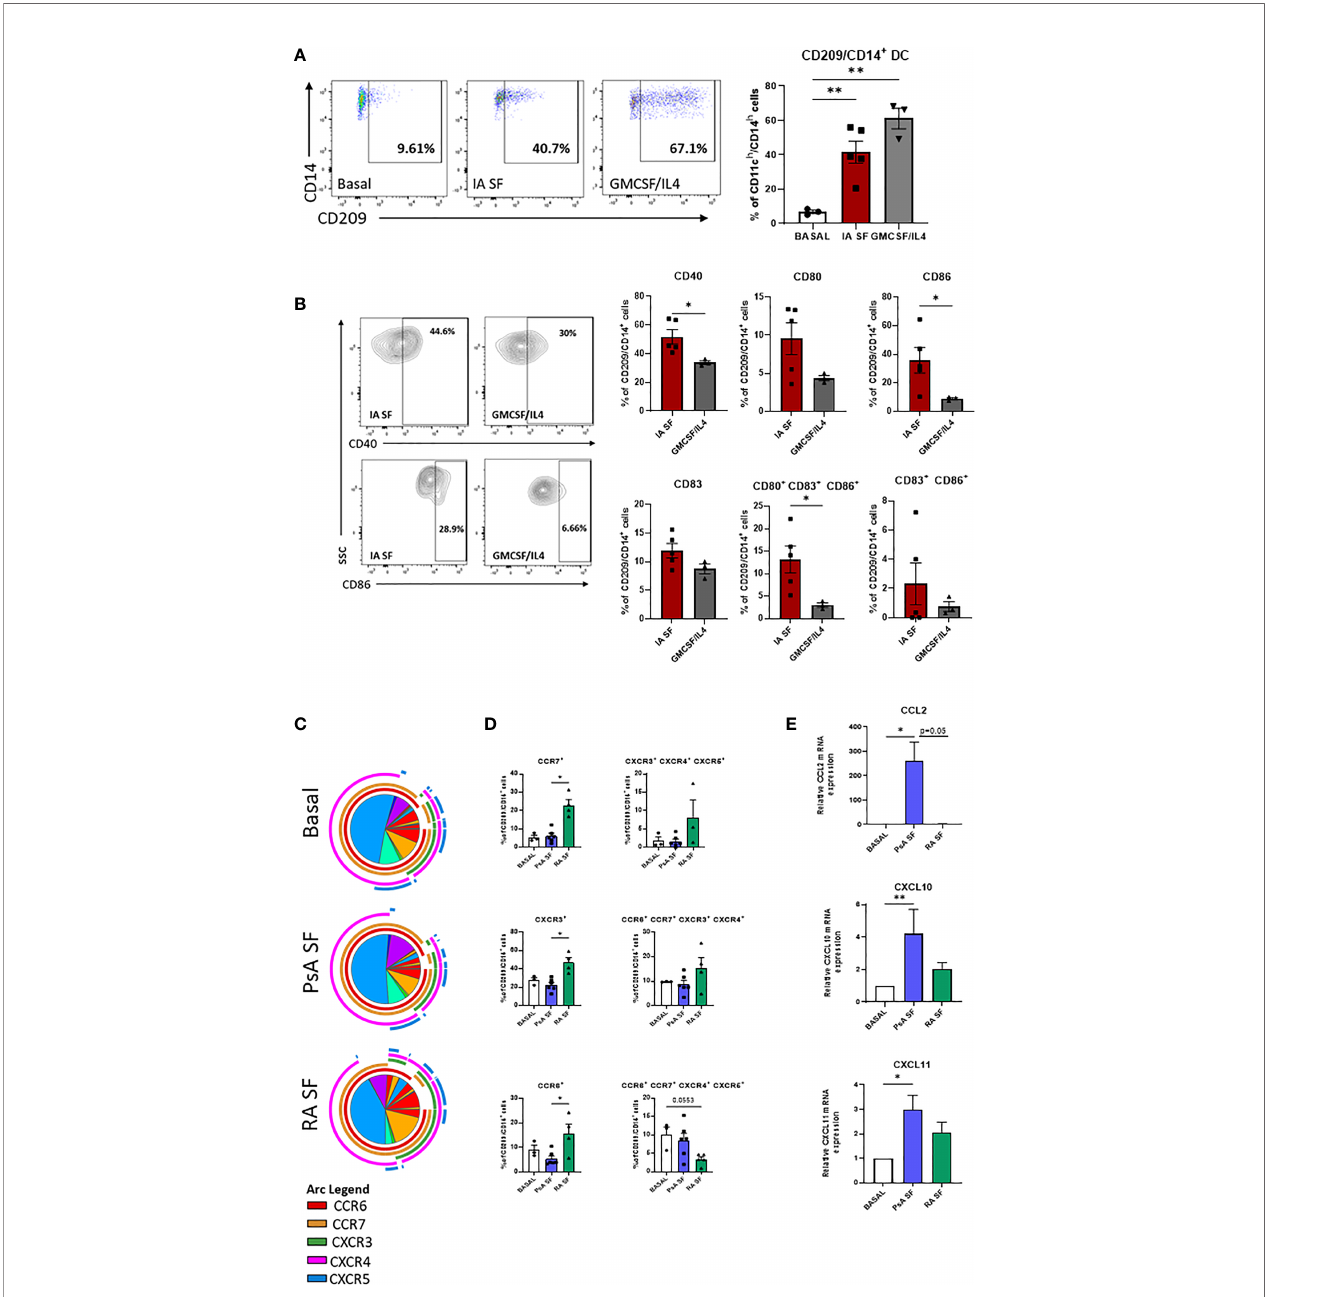
FIGURE 4 | RA and PsA micro-environment modulate CD209/CD14 + DC development and activation. (A) Left, Representative fl ow plot of lineage negative cells from HC (n=2) left untreated (Basal n=3), treated with 20% IA synovial fl uid (SF n=4), or with GMCSF/IL4 (n=3) cocktail. Right, histogram representing the frequency of CD209/CD14 + DC. Data are represented as mean ± SEM and differences among groups were evaluated by non-parametric One-way ANOVA. **p < 0.01. (B) histograms representing frequency of the maturation markers CD40, CD80, CD83, CD86 singularly expressed or combinations. Data are represented as mean ± SEM and differences among groups were evaluated by non-parametric t-test (Mann-Whitney test) *p < 0.05. (C) SPICE algorithm fl ow cytometric analysis of isolated CD209 + DC from HC left untreated (n=3) or stimulated with 20% SF from PsA (n=6) and RA (n=4), displaying the frequency of the chemokines receptors CCR6 (red arc), CCR7 (yellow arc), CXCR3 (green arc), CXCR4 (pink arc) and CXCR5 (blue arc) and (D) corresponding histograms representing the expression and co- expression of the chemokine receptors. Data are represented as mean ± SEM and differences among groups were evaluated by Non-parametric One-way ANOVA, Kruskal-Wallis test *p < 0.05. (E) qPCR displaying the relative gene expression of CCL2 , CXCL10 and CXCL11 in isolated CD209 + DC from HC left untreated (n=4) or stimulated with 20% SF from PsA (n=5) and RA (n=5). Relative expression to basal was calculated with the 2 – DD Ct method. Data are represented as mean ± SEM and differences among groups were evaluated by Non-parametric One-way ANOVA, Kruskal-Wallis test *p < 0.05, **p <